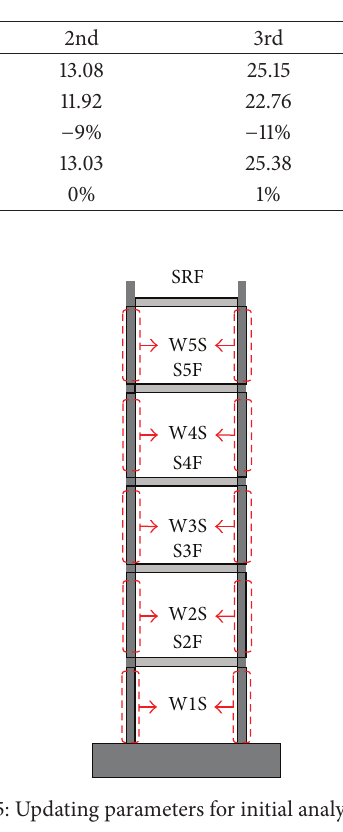
Table 3: Natural frequencies of reference model.